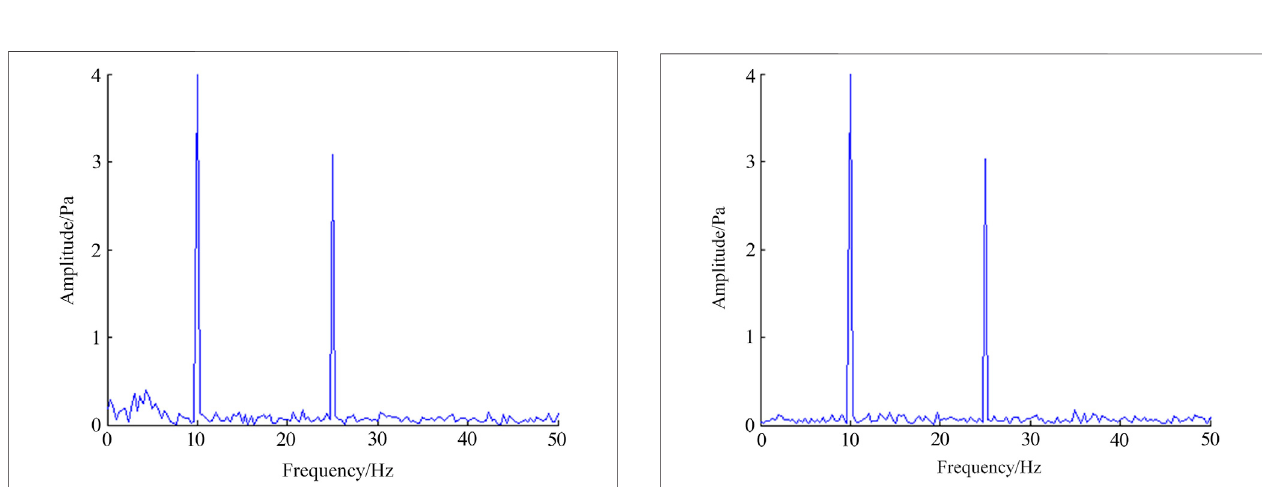
FIGURE 13 | Waveform after denoising by improved EMD.